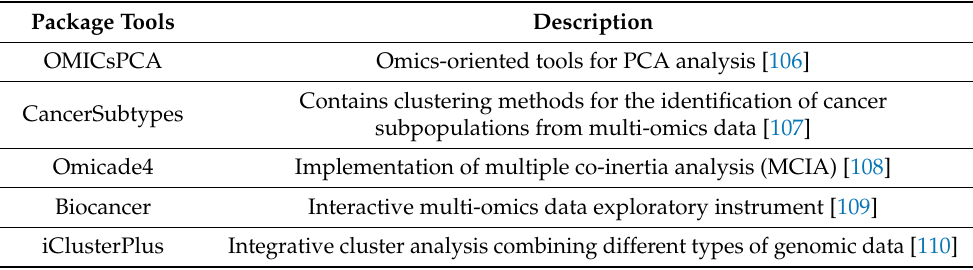
Table 2. Main cluster analysis and dimension reduction package tools applied to cancer studies. Package Tools Description OMICsPCA